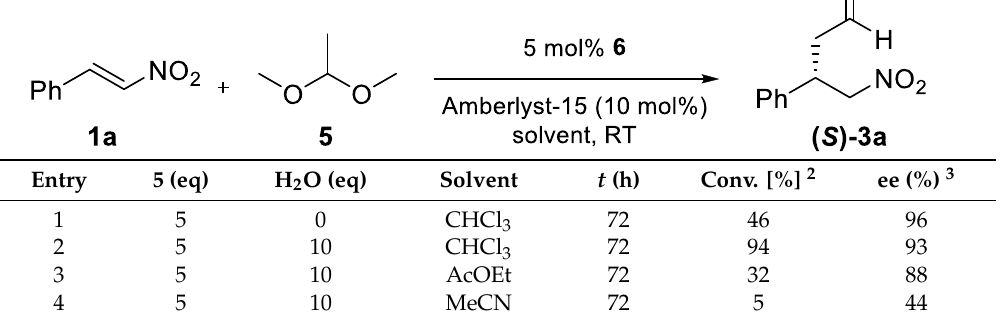
Table 2. Optimization of conditions for the Michael addition 1.